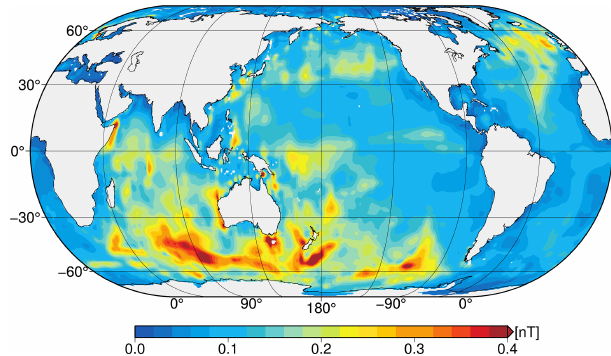
Figure 7. Annual temporal variability (standard deviation) of the reference ocean-induced magnetic